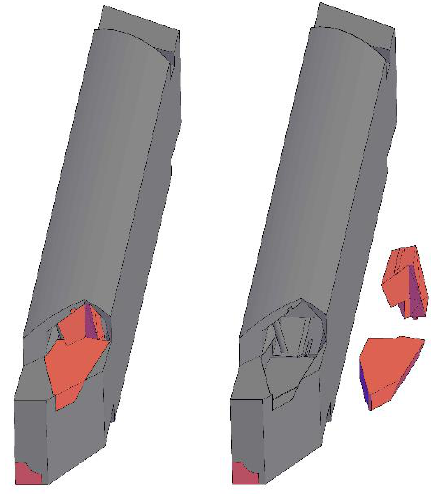
Figure 18. The rear insert fixed in the grooves.